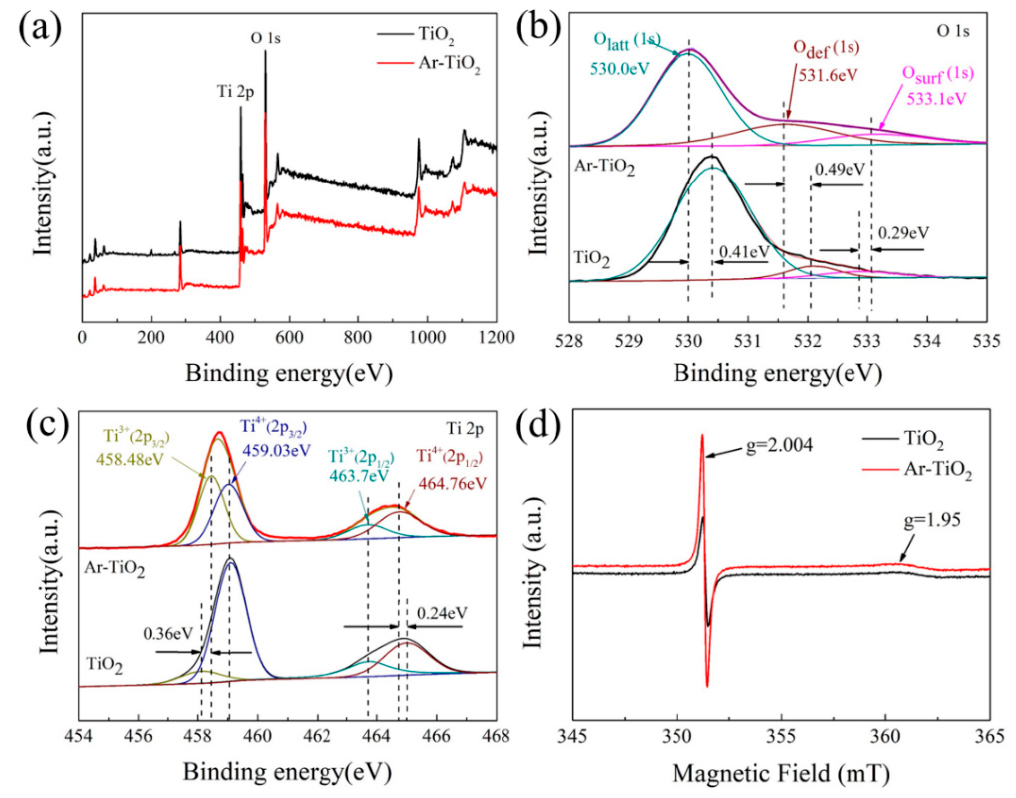
Figure 2. X-ray photoelectron spectroscopy (XPS) spectra of ( a ) survey spectra, ( b ) O 1s, ( c ) Ti 2p and ( d ) Electron paramagnetic resonance (EPR) spectra for the Ar-TiO 2 and pristine TiO 2 catalysts.